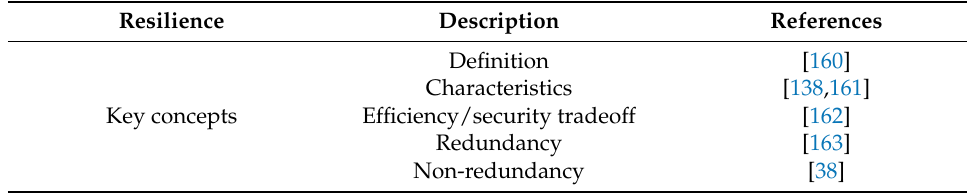
Table 3. Key references about covert network